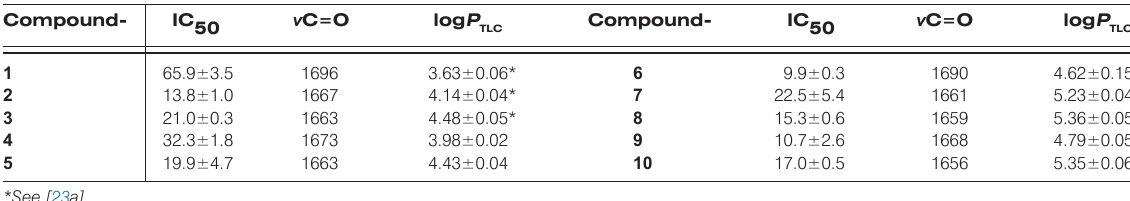
Table 1. In vitro IC50 values (µM) against P388 murine leukemia cells, ν C=O IR frequencies (in 0.05 M CHCl of compounds 1 - 10 .